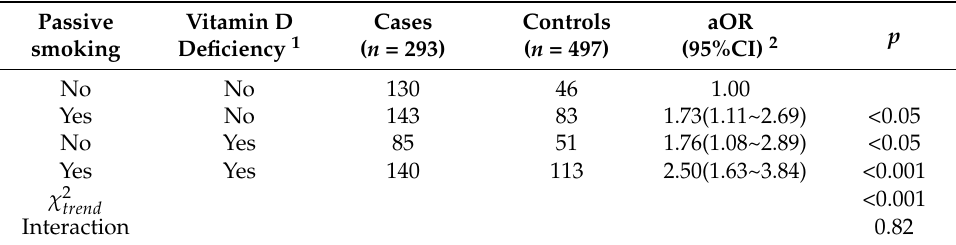
Table 3. Risk of spontaneous abortion across different combination groups of passive smoking and vitamin D